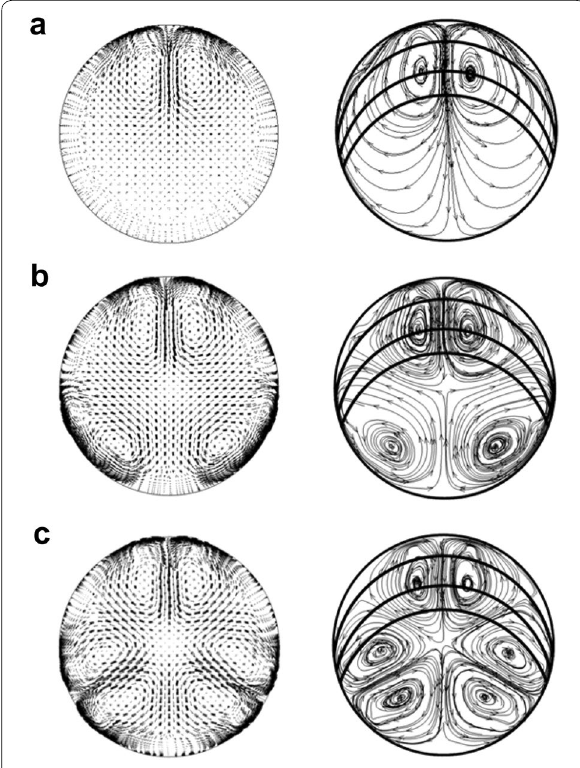
Fig. 4 Tangential velocity vectors and streamlines at section z 905 mm, a Type-1, b Type-2 and c Type-3; the solid lines in each = streamline picture are critical light intensity when I 0 1200 μmol m − 2 s − 1 from the top to center,